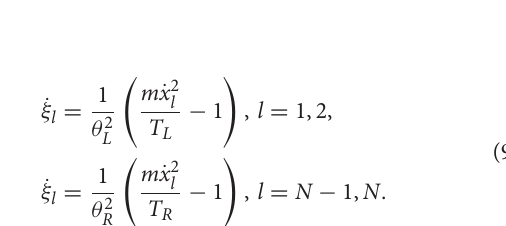
FIGURE 1 | (Left) Plot of the displacement of the mean position of particle i from its mechanical equilibrium position, ( second neighbors interaction, when T L a function of N ranging from 64 to 6000, for N > 400. The label of the particle corresponding to the maximum lattice distortion is fitted by i mld R 2 =